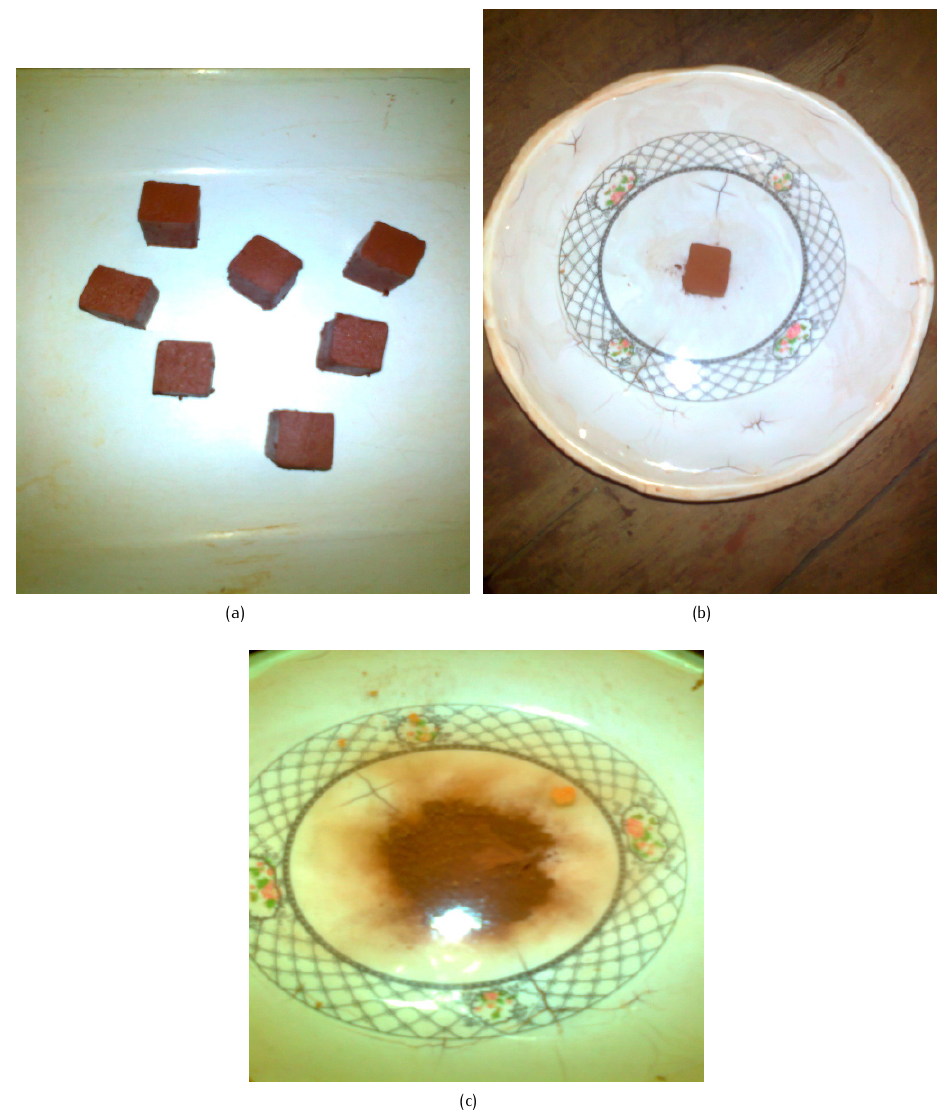
Figure 7. Crumb test showing (a) Prepared samples before test (b) A sample just placed in distilled water (c) Sample in distilled water after seven minutes